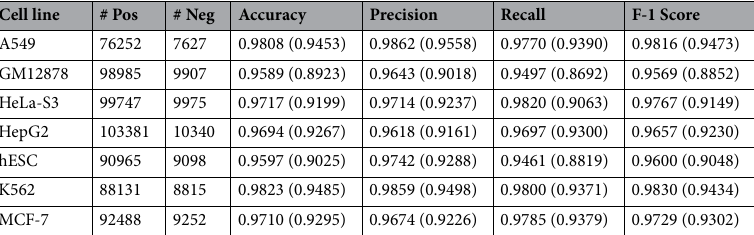
Cell line # Pos # Neg Accuracy